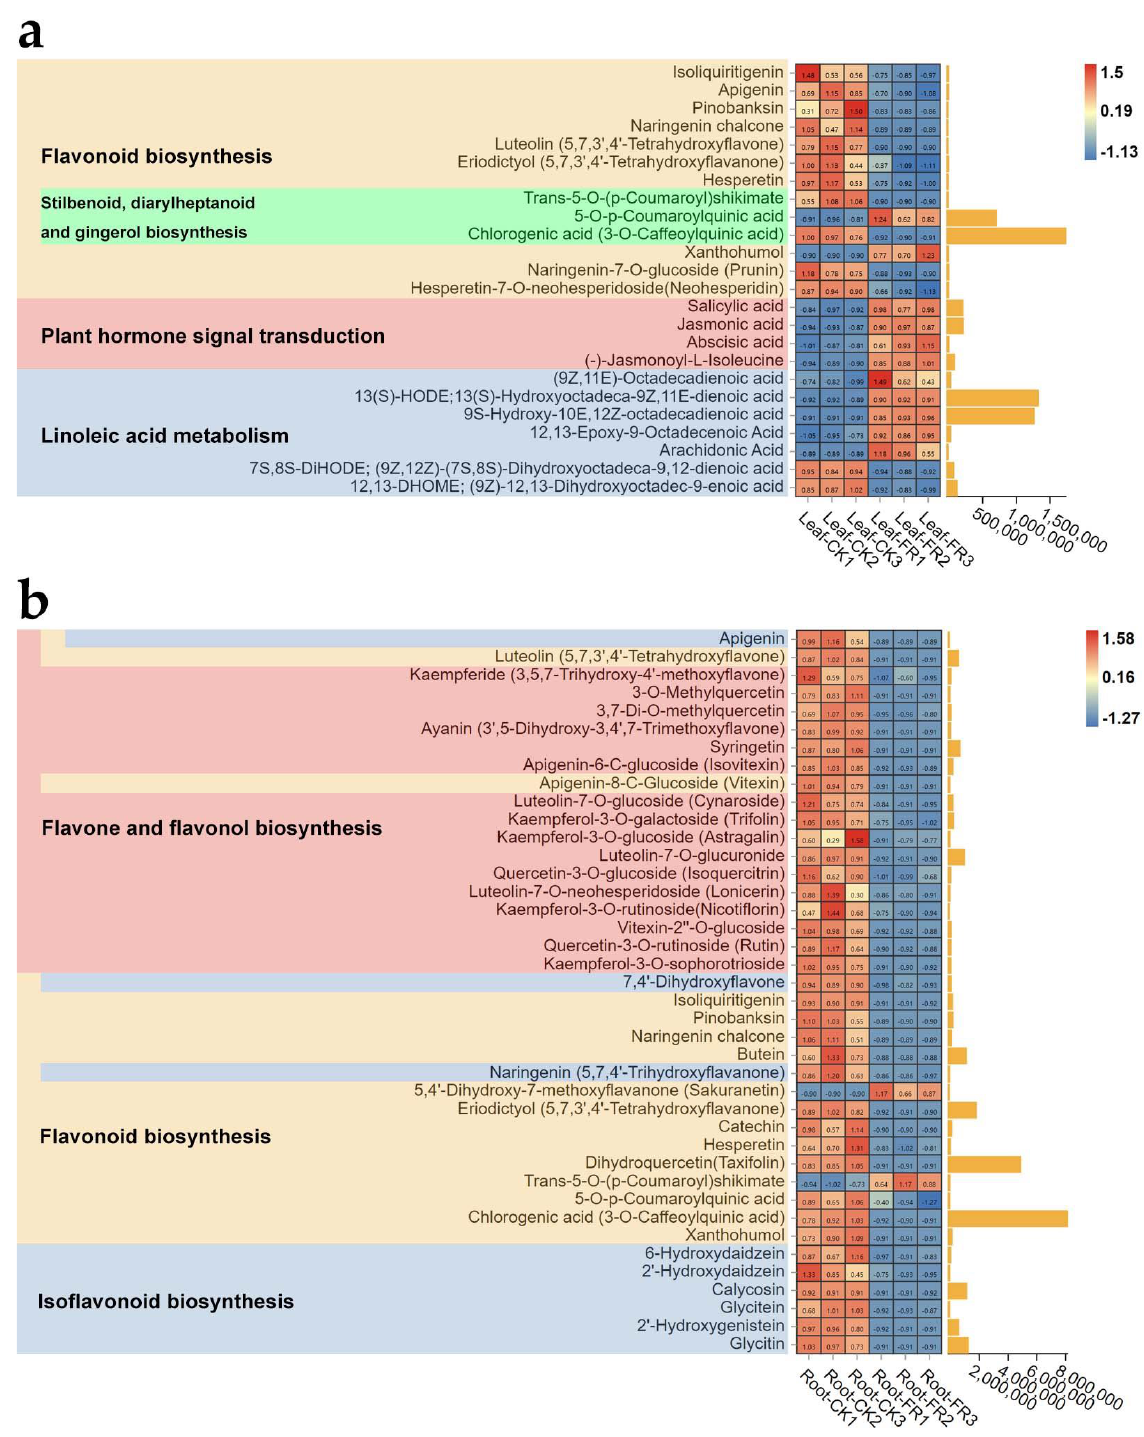
Figure 8. Heat map and histogram showing the KEGG pathways significantly enriched by the differential metabolites in the ( a ) leaf and ( b ) root CK and FR comparison groups (Leaf-CK vs. Leaf-FR, Root-CK vs. Root-FR) of the fairy rings. In the heat map, the abscissa shows the leaf and root samples, and the ordinate represents the metabolites; the color of each grid represents the abundance of metabolites in the sample (normalized by Z-score). In the histogram, the abscissa represents the unit size of the corresponding peak area units; the higher the column, the greater the difference. The pathway to which the metabolite belongs is shown on the left, and the metabolite with multiple colors participates in various pathways. E.g., red means flavone and flavanol biosynthesis pathway.